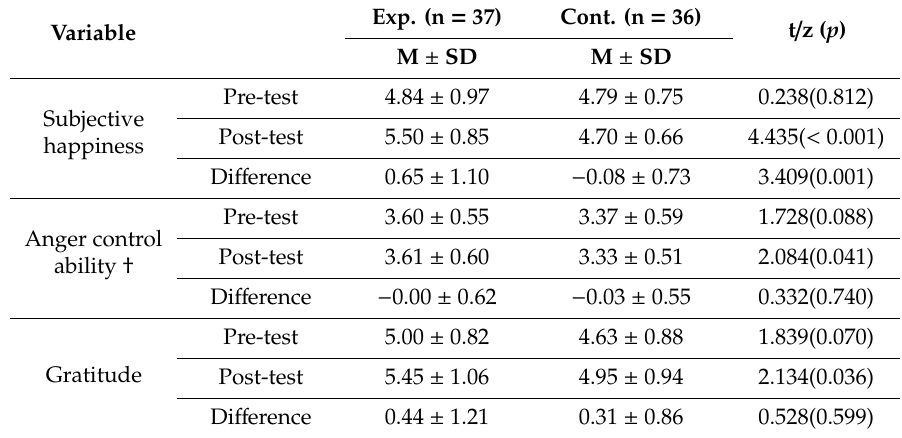
Table 4. Comparison of subjective happiness, gratitude, and anger control ability between two